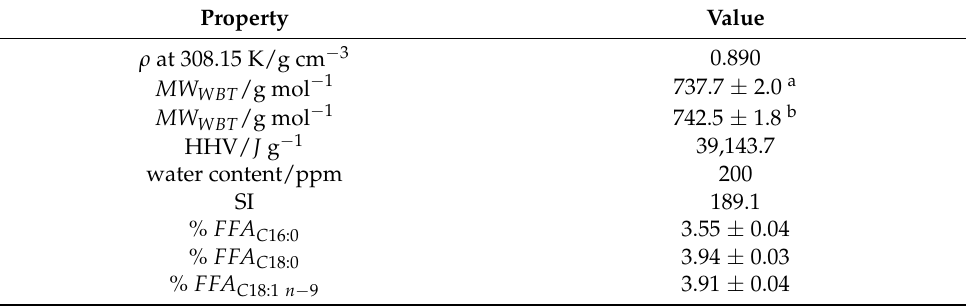
Table 1. Physicochemical properties of waste beef tallow (WBT) [56].